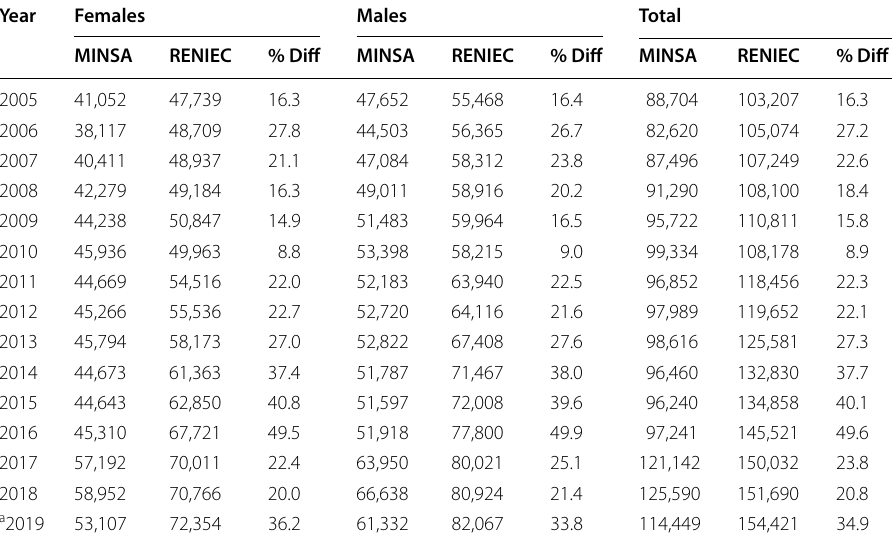
Table 2 Difference between the number of deaths published by the Ministry of Health and the civil registry by year and sex, from 2005 to 2018,